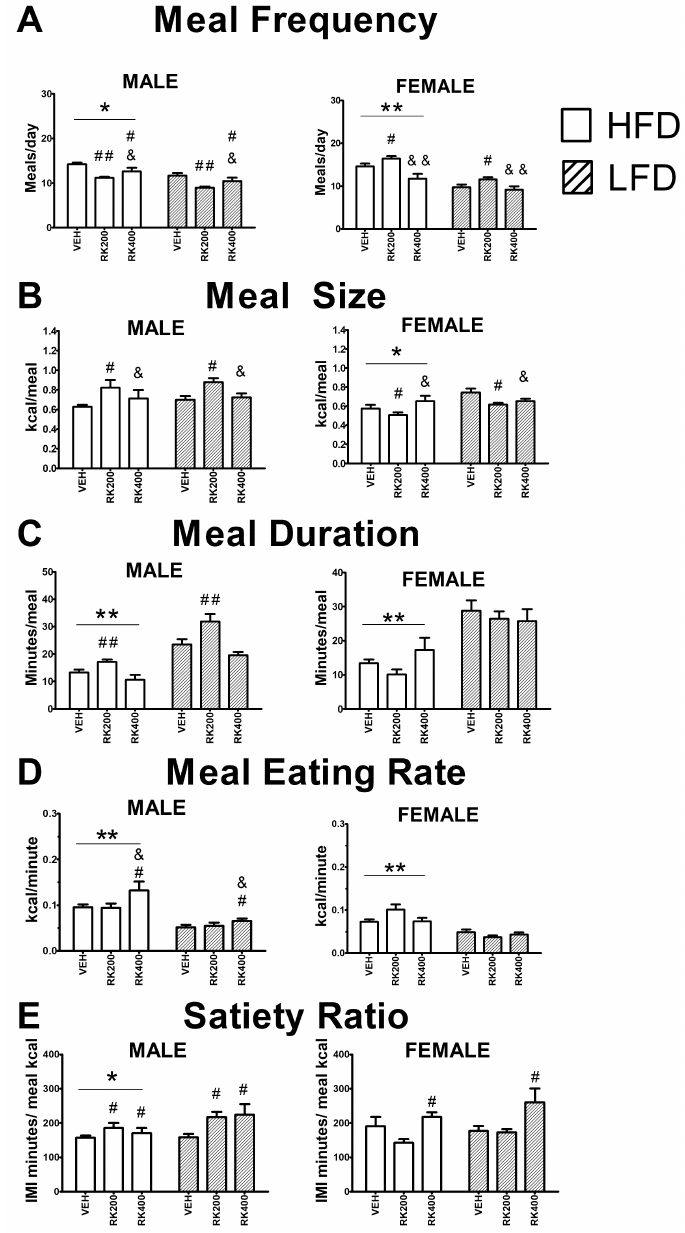
Figure 2. Average meal patterns over the 14 days of daily oral RK and diet access. Meal patterns are from the nocturnal period. Data are represented as means ± standard error of the mean (SEM). High-fat diet (45% fat; HFD, solid lines) and low-fat diet (10% fat; LFD, stripped line) and oral gavage with raspberry ketone (RK) or vehicle (50% propylene glycol, 40% water, and 10% dimethyl sulfoxide; DMSO) for 14 days. Comparisons are separate within each sex. Meal patterns were averaged over fourteen days of dosing and diet exposure. ( A ): Meal frequency; average number of meals each day, ( B ): meal size (kcal), ( C ): meal duration (min), ( D ): meal eating rate (kcal / min), and ( E ): satiety ratio (inter meal interval in min / kcal). * indicates overall diet di ff erence from LFD ( p < 0.05), ** indicates overall diet di ff erence from LFD ( p < 0.005), # indicates overall dose di ff erence from vehicle ( p < 0.05), ## indicates overall dose di ff erence from vehicle ( p < 0.01), && indicates overall dose di ff erence from RK200 dose ( p < 0.001), & indicates overall dose di ff erence from RK200 dose ( p < 0.05). HFD-Vehicle (males: n = 14, females n = 4, HFD-RK (200 mg / kg) (males: n = 8, females: n = 6), HFD-RK (400 mg / kg) (males: n = 7, females: n = 6), LFD-Vehicle (males: n = 16, females: n = 8) LFD-RK (200 mg / kg)(males: n = 7, females: n = 8), and LFD-RK (400 mg / kg)(males: n = 8, females: n =